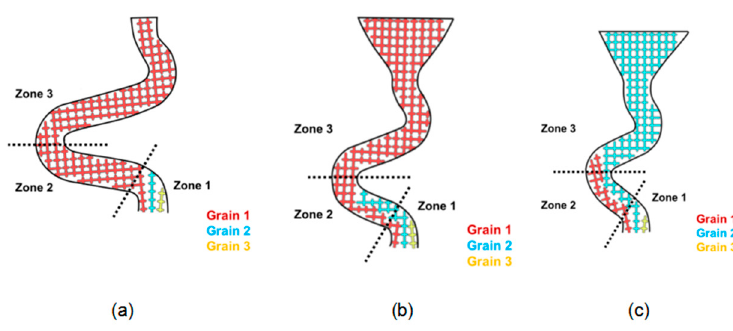
Figure 9. Schematic drawings of the grain growth process in Z-form grain selectors with various take-off angles: ( a ) 15°, ( b ) 30°, ( c ) 40°.